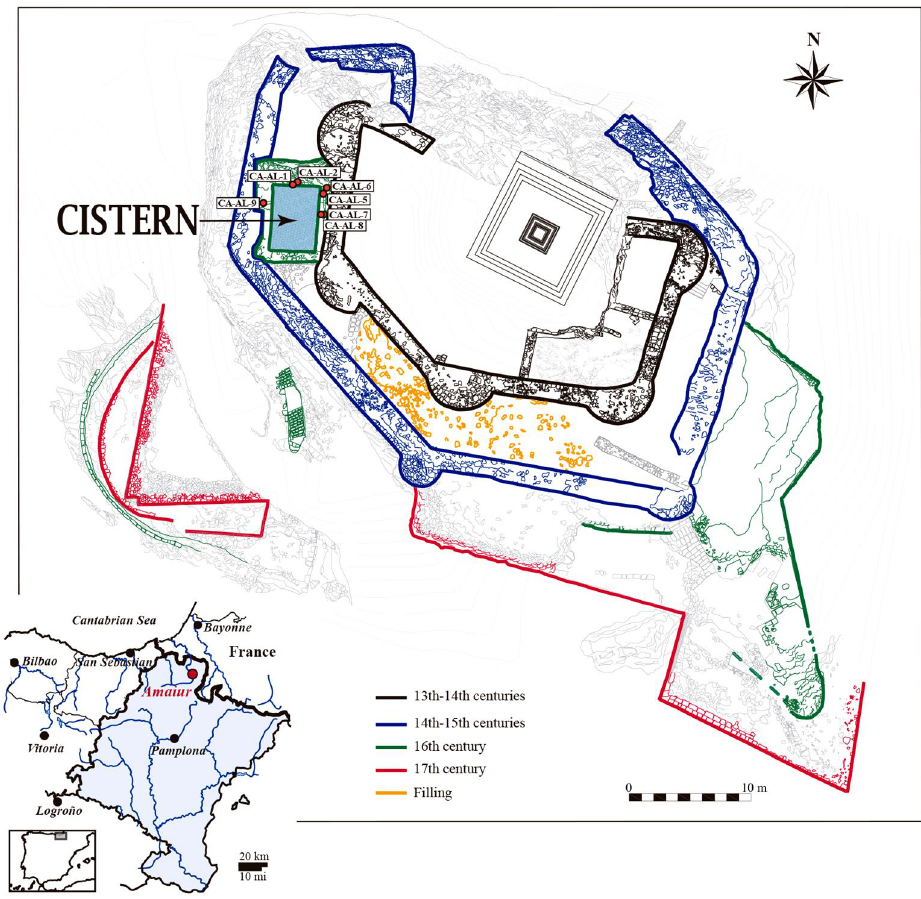
Figure 1. Geographic location of Amaiur Castle (Navarre, Spain). Studied samples are marked by red circles. Modified from Ponce-Antón et al. [23]. Table 1. Lime mortar samples from the different locations in Amaiur Castle cistern.